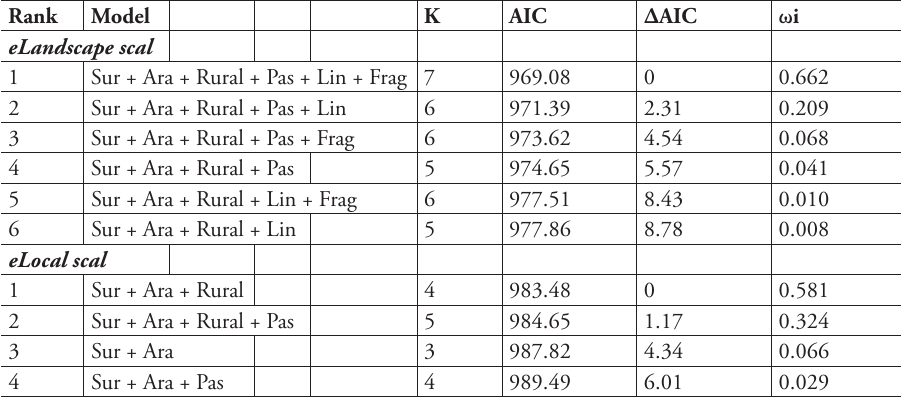
table 2. Model selection results for the effect of landscape variables on the occurrence of Metrioptera roeselii . The model selection statistics are number of parameters (K), Akaike’s information criterion (AIC), difference between model and minimum AIC values (∆AIC), and AIC weights ( ω i). Only models with ∆AIC < 10 are shown.